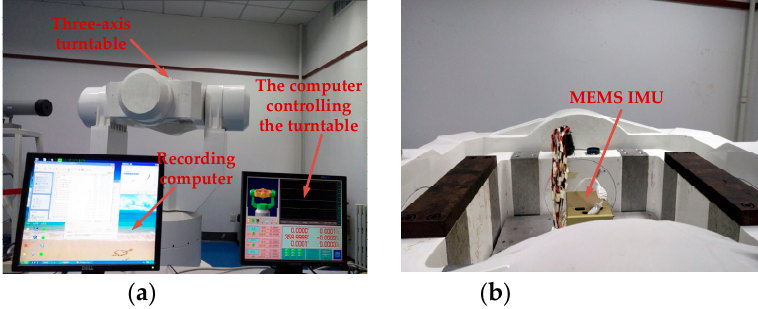
Figure 6. ( a ) Experimental environment; ( b ) the MEMS IMU (inertial measurement unit) used in the experiment.